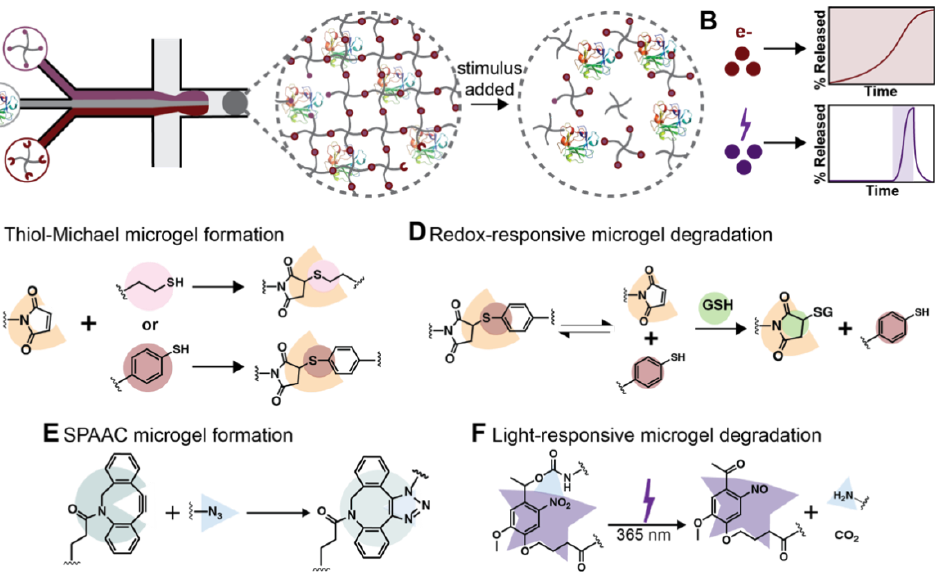
Figure 1. Overview of approach. ( A ) Microgels were formed between end-functionalized four-arm PEG macromers and containing a model biopolymer using MFF. The resulting hydrogel network encapsulated the model cargo that is released upon the addition of a stimulus. ( B ) Redox (e-labeled population) and light (lightning bolt labeled population) responsive microgel populations were formed and can be utilized to create different release profiles based on the degradable content within redox-responsive populations, for achieving tunable and sustained release, and when light is applied to the system, for achieving triggered burst release, respectively. ( C ) Thiol-Michael additions between PEG-4-maleimides and PEG-4-alkyl-thiols or PEG-4-aryl-thiols were utilized to form redox-responsive microgels. ( D ) The use of PEG-4-aryl-thiols introduces a mechanism for redox-responsive behavior through the retro-Michael addition and subsequent reaction with endogenous thiols, such as glutathione (GSH), for network degradation. ( E ) Microgels were also formed using a SPAAC reaction between PEG-4-DBCO and PEG-4-NB-azide, and ( F ) light degradability was imparted through the incorporation of NB moieties within the microgel crosslinks.